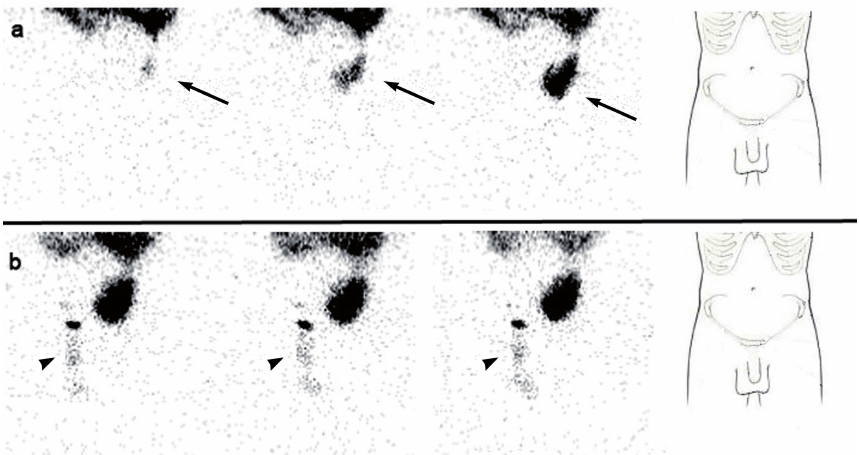
figure 1 - Dynamic peritoneal 99mTc-phytate scintigraphy. panel a: Images acquired during the filling of peritoneal dialysis solution (600, 1200 and 2000 ml) labeled with 74 MBq of 99mTc phytate, revealing a hypogastric uptake of radiotracer (arrow), not reaching the inguinal canal or the scrotal area. On the right side, anatomical reference contour. panel b: Inguinal and right scrotal uptake of radiotracer (head arrow) after valsalva’s maneuver. On the right side, anatomical reference